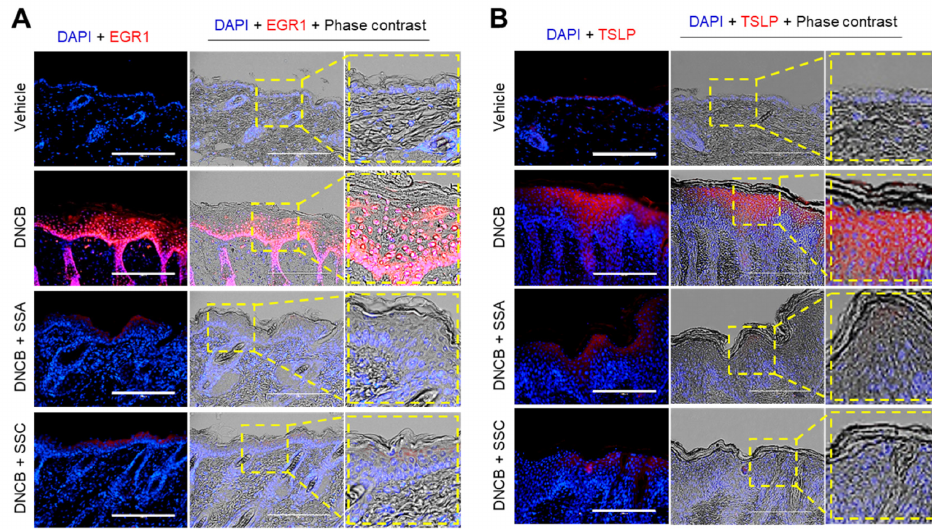
Figure 9. SSA and SSC reduce the enhanced expression of both EGR1 and TSLP in DNCB-challenged BALB/c mice. BALB/c mice were treated with vehicle (70% ethanol), DNCB + 0.5% SSA, or DNCB + 0.3% SSC. Paraffin-embedded skin tissue sections were deparaffinized and incubated with anti- EGR1 ( A ) and anti-TSLP primary antibodies ( B ), followed by incubation with rhodamine red-X- conjugated secondary antibody (red). Nuclei were counterstained with Hoechst 33258 (blue). Scale bars = 200 µ